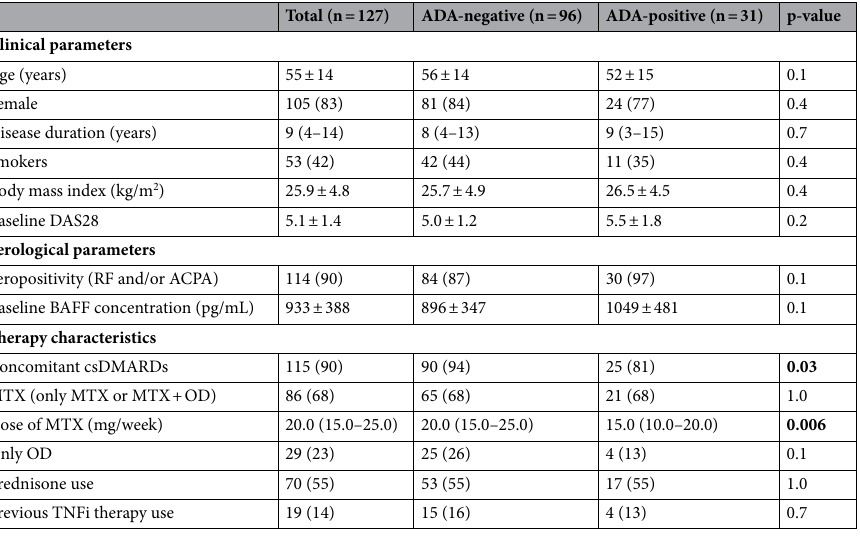
Table 1. Baseline patients’ characteristics. The table shows mean ± SD, median (IQR) or absolute number (percentage) for all patients included (n = 127). The results are also stratified by anti-drug antibody seropositivity. Significant statistical differences are noted in bold. p-value < 0.05 was considered statistically significant. RF rheumatoid factor, ACPA anti-citrullinated peptide antibody, BAFF B cell activating factor, csDMARDs conventional synthetic disease-modifying anti-rheumatic drug, DAS28 disease activity score-28, TNFi TNF inhibitor, MTX methotrexate, OD other